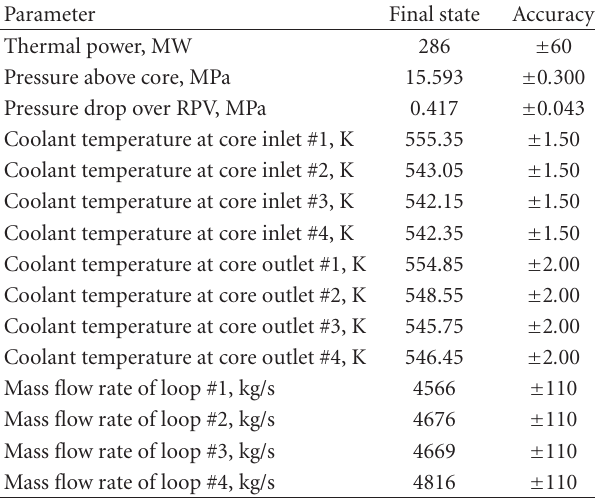
Table 5: Main parameters of the NPP at the end of the test (1800 seconds).